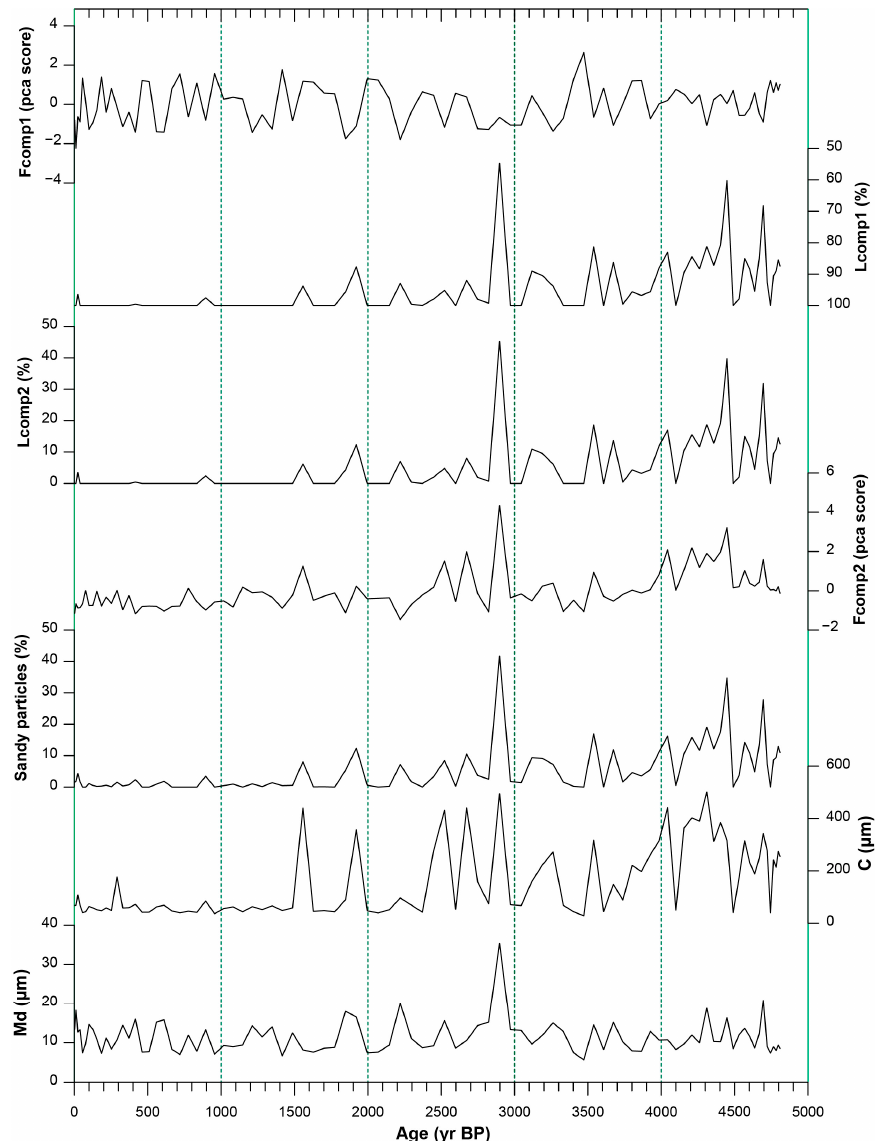
Figure 4. Changes in sediment grain-size parameters of core ECS-DZ1.